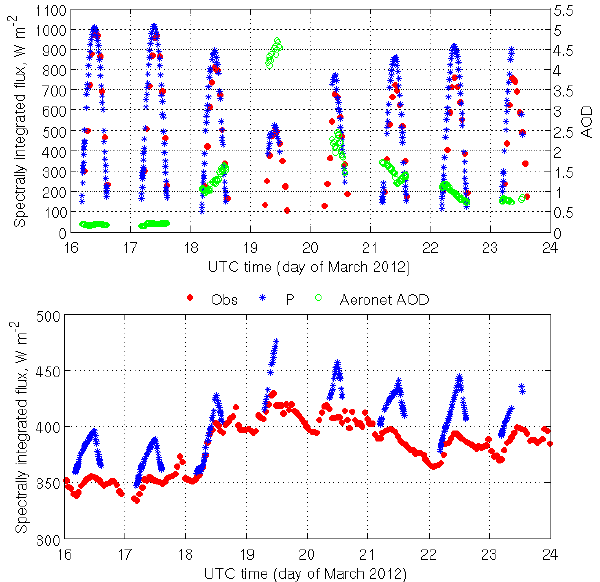
Figure 8. SW (top panel) and LW (bottom panel) perturbed experi- ment (P, black) and satellite-inferred (GERB, red and CERES, blue) TOA upwelling fluxes at KAUST. Cloudy area percent coverage de- rived from CERES product (top panel, green) is plotted against the right vertical